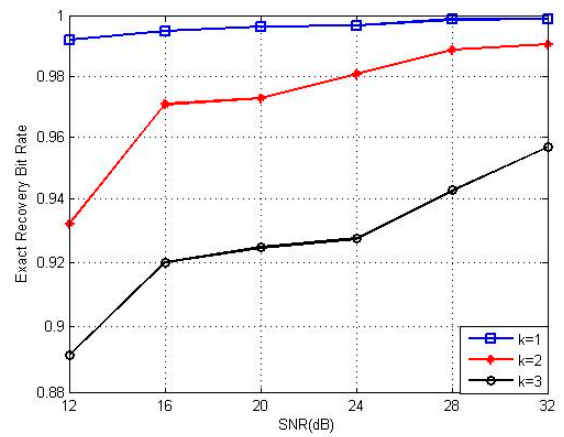
Figure 4. Recovery performance under different SNRs at different K values.